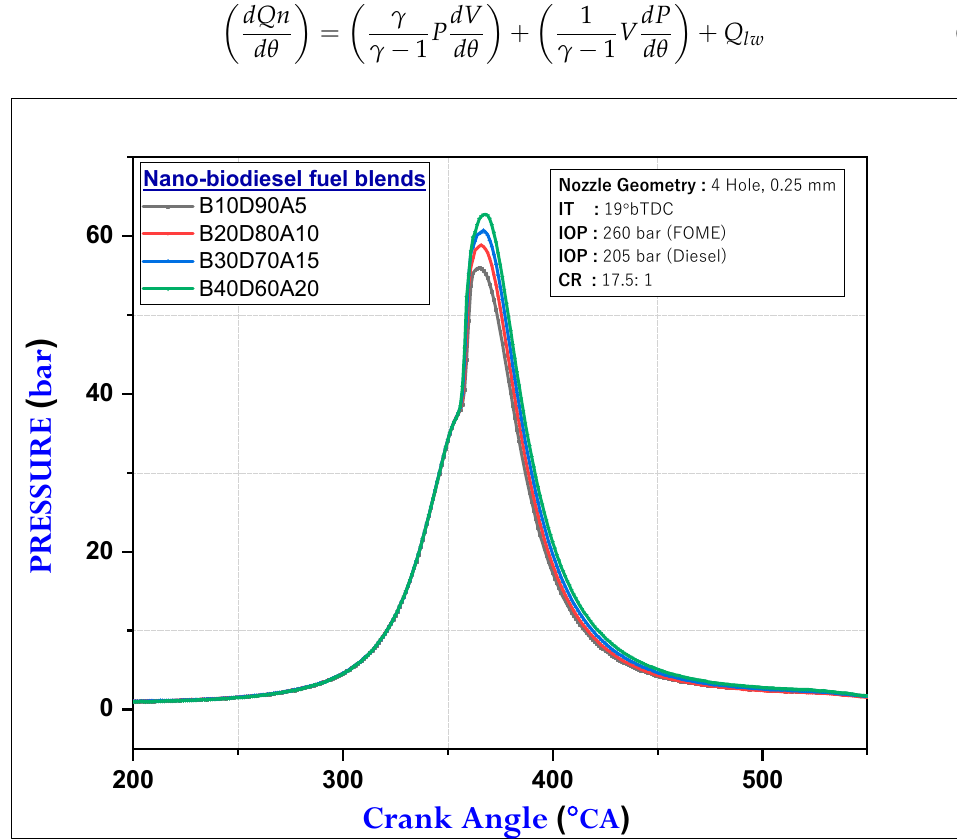
Figure 13. Variation in in-cylinder pressure with crank angle at 100% load.